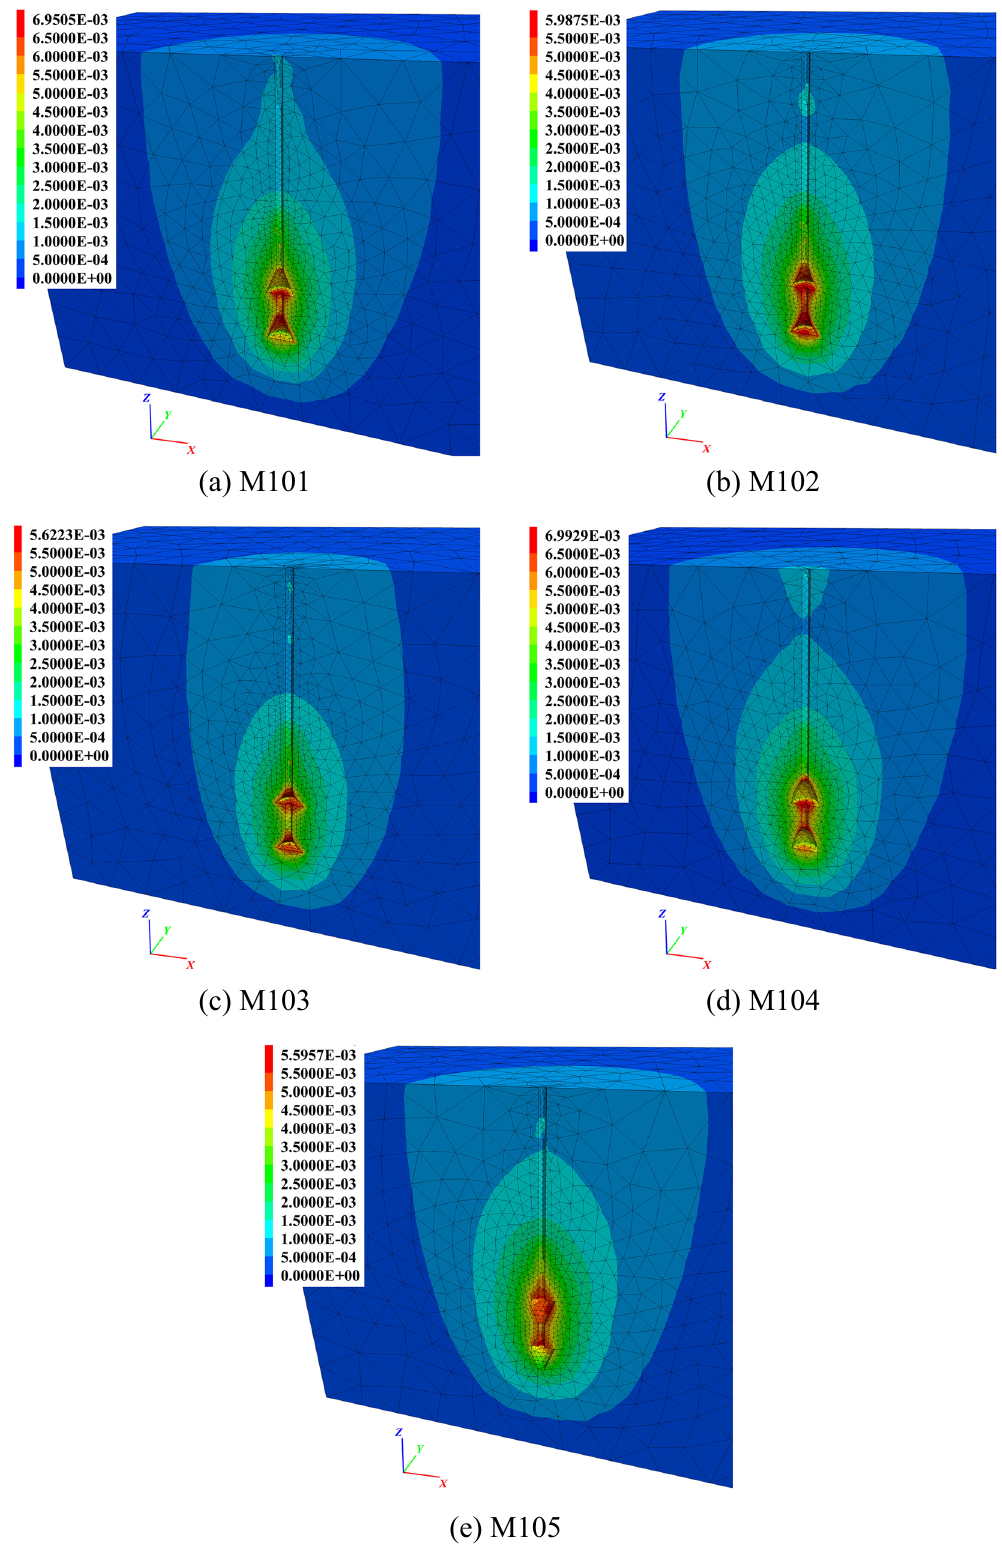
Figure 11. Soil vertical displacement contours of group M1 at 1.0 t . ( a ) M101. ( b ) M102. ( c ) M103. ( d ) M104. ( e )